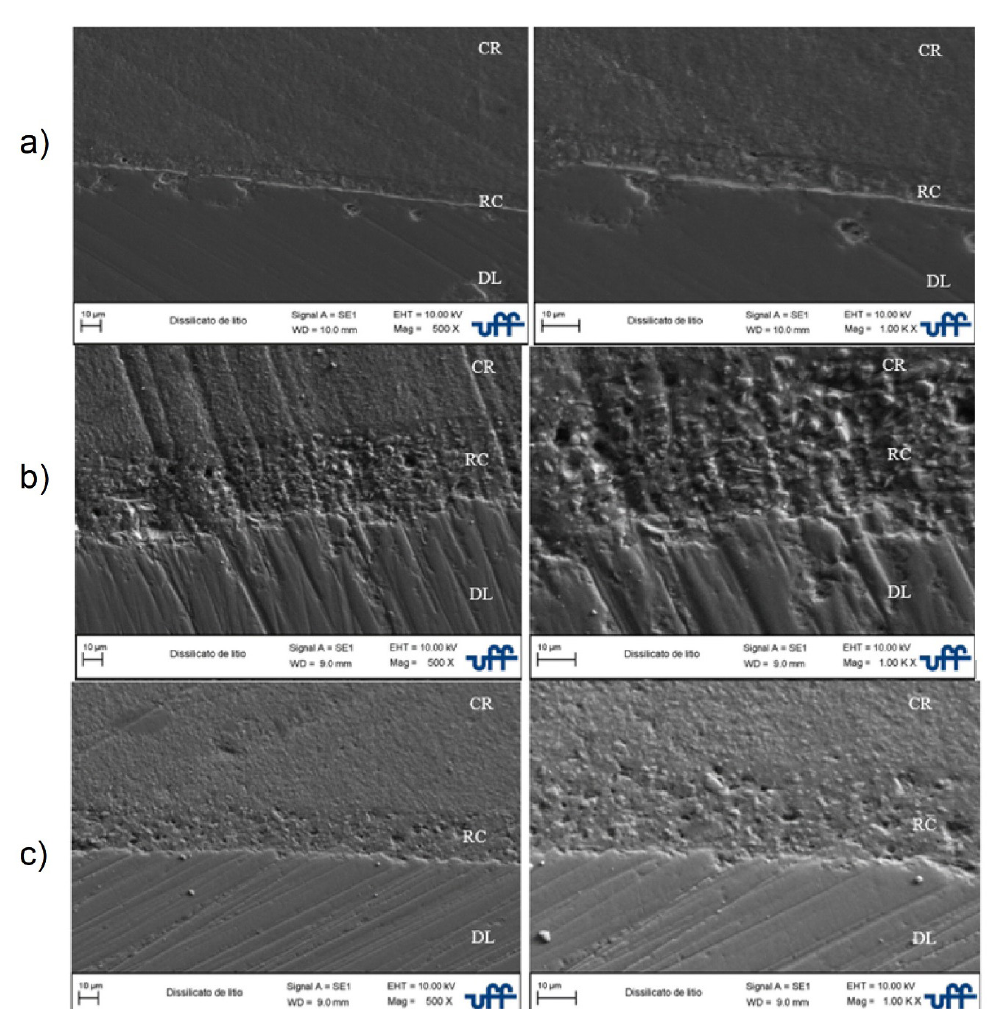
Figure 8. Weibull diagram and probability of failure of the ceramic-resin